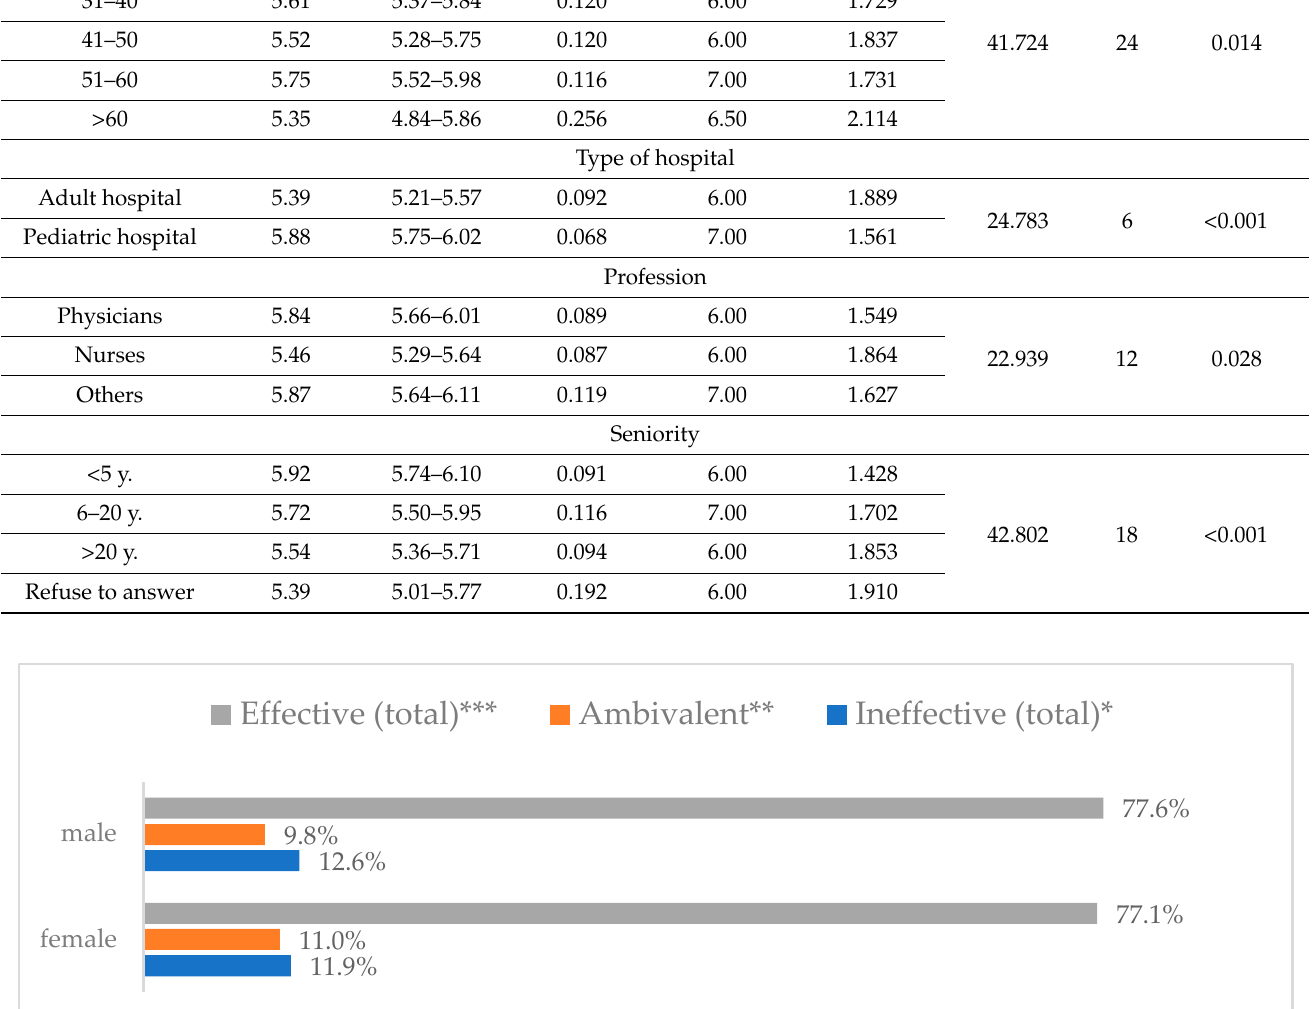
Figure 16 . Avoiding contact with sick people to prevent influenza virus infection by gender ( N = 905). *Sum of responses: completely ineffective, ineffective, rather ineffective; **Response: neither ineffective nor effective; *** Sum of responses: rather effective, effective, completely effective.